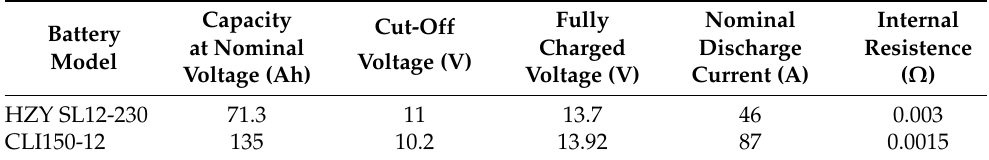
Table 3. Main parameters used in Simscape battery